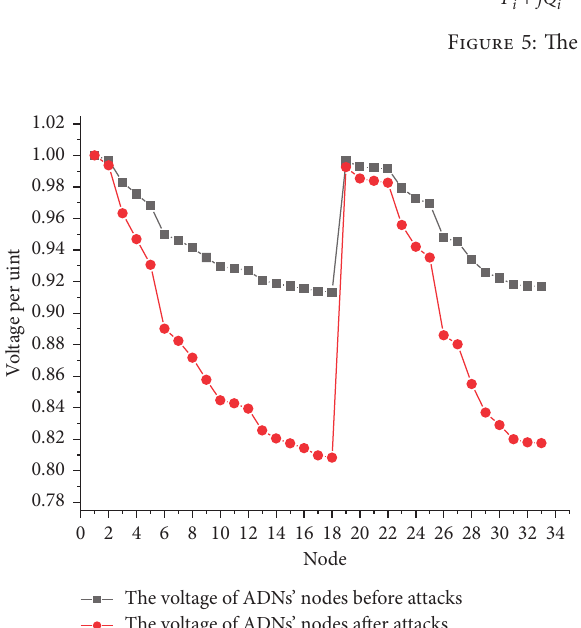
Figure 6: The voltage unit value of ADN nodes before and after A I attack.